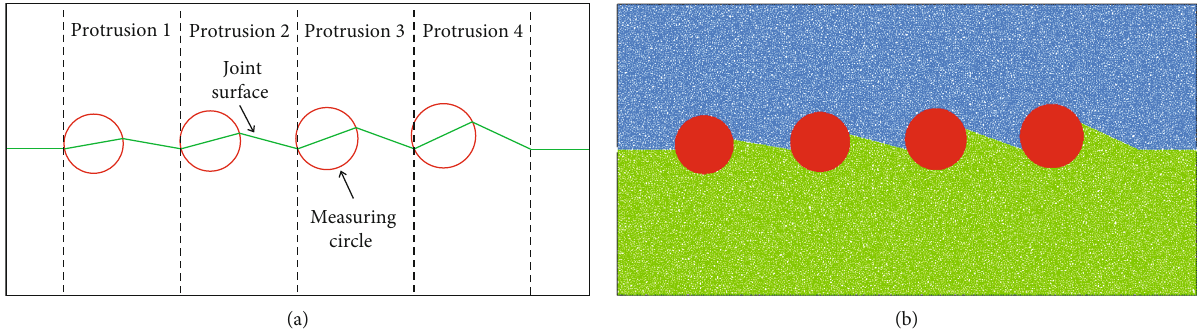
Figure 15: Layout of measuring circles: (a) layout scheme; (b) actual